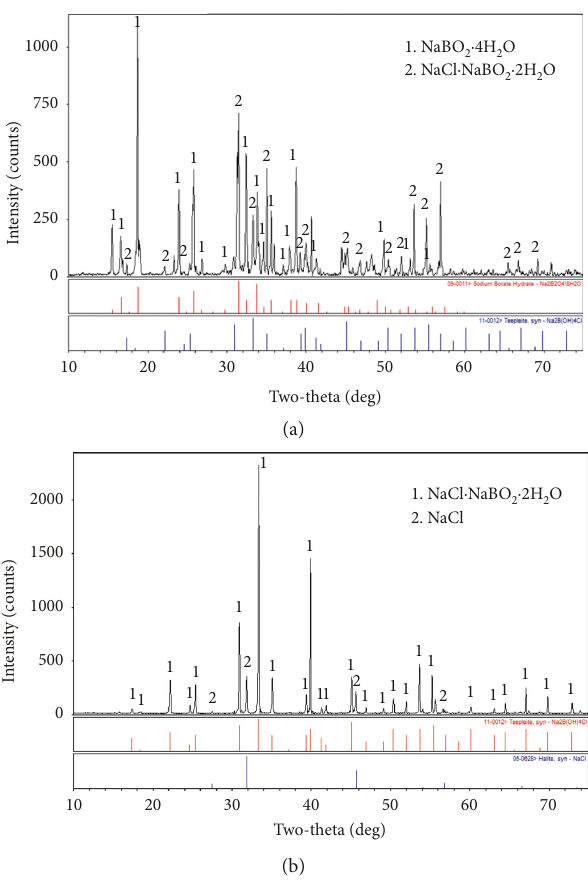
Figure 2: X-ray diffraction photograph of the invariant points for the ternary system (NaCl+NaBO 2 +H 2 O). (a) Invariant points E 1 and E